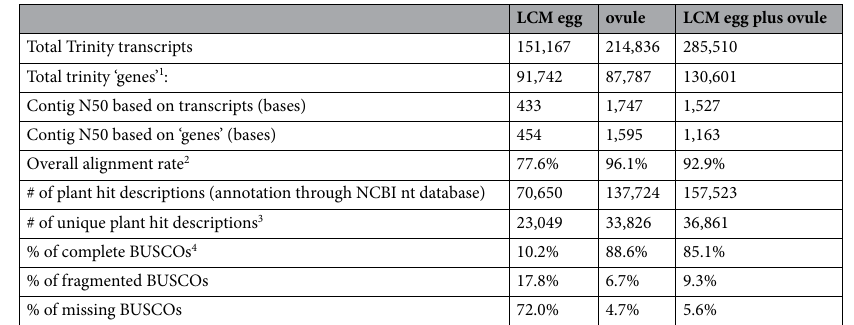
Table 2. Basic statistics, completeness and number of unique plant hit descriptions for each de novo assembly. 1 Transcripts that were grouped into clusters based on shared sequence content. 2 The percentage of RNA-seq reads that mapped back to the transcriptome assembly. 3 Non-redundant plant hit descriptions. 4 Benchmarking Universal Single-Copy Orthologs.